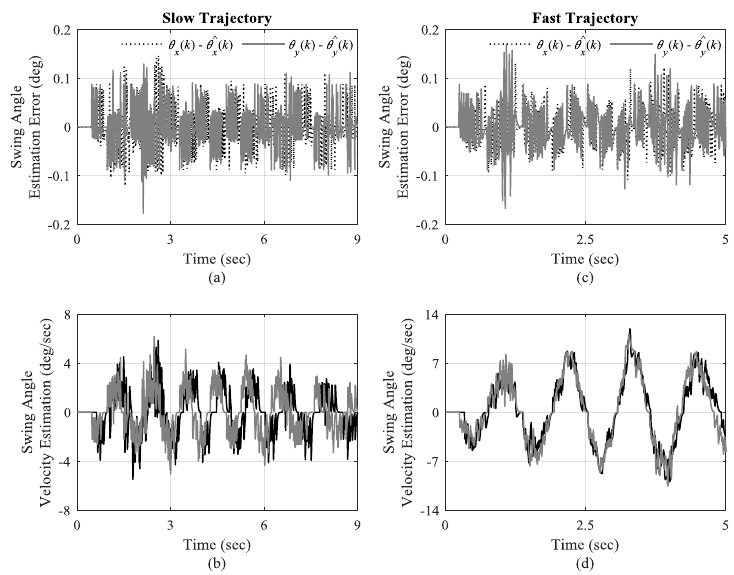
Figure 10. ( a ) and ( b ): Estimation error of swing angle and their velocities estimates for slow trajectory, respectively; ( c ) and ( d ): Estimation error of swing angle and their velocities estimates for fast trajectory, respectively.